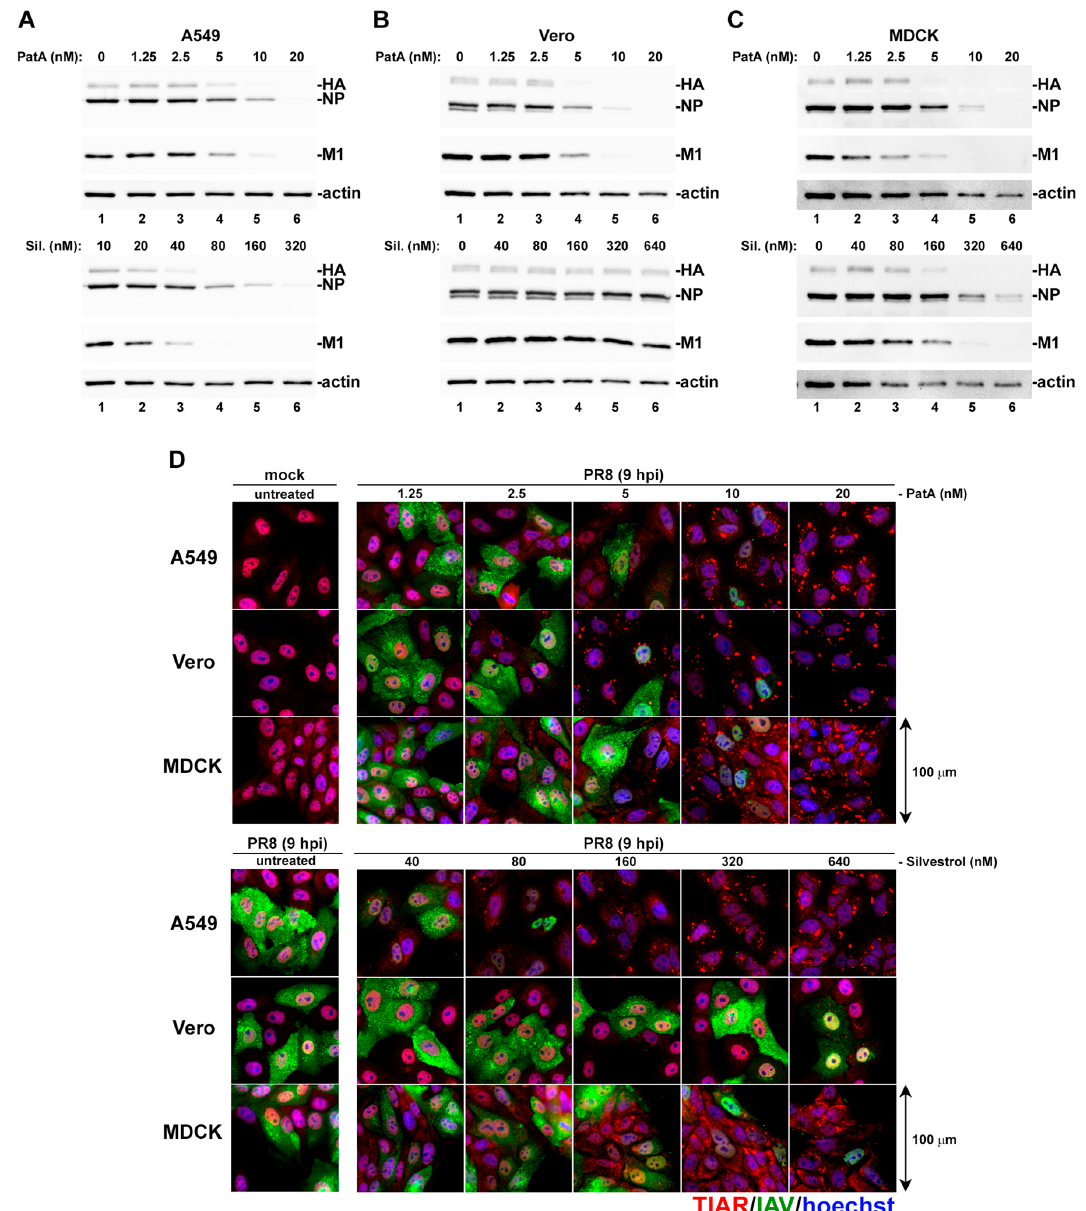
Figure 1. Concentration-dependent stress granule induction and inhibition of viral protein accumulation by pateamine A (PatA) and silvestrol (Sil.). A549, Vero, and MDCK cell lines infected with PR8 strain of influenza A virus (IAV) were treated with the indicated concentrations of PatA or Sil. at 1 hpi. ( A – C ) Viral protein accumulation was analyzed in whole cell lysates collected at 24 hpi by western blot. ( D ) Stress granule induction and viral protein accumulation were visualized at 9 hpi by immunofluorescence microscopy using an antibody to stress granule marker TIAR (red) and a polyclonal anti-influenza antibody (green). Nuclei were stained with Hoechst dye (blue). Representative images are shown for each cell line and treatment condition. There were three biological replicates of A549 cell experiments, and two biological replicates for Vero and MDCK cell experiments.